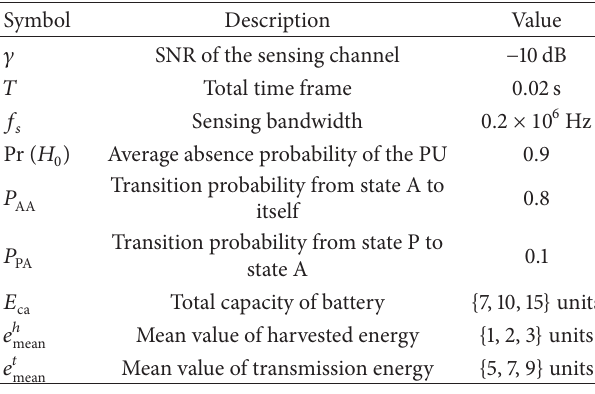
Table 1: Simulation parameters.